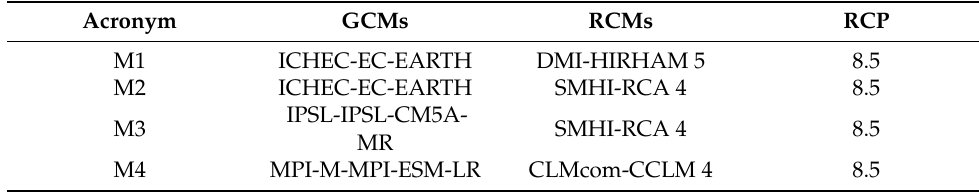
Table 2. GCM and RCM combination, and RCP of the selected climate models.